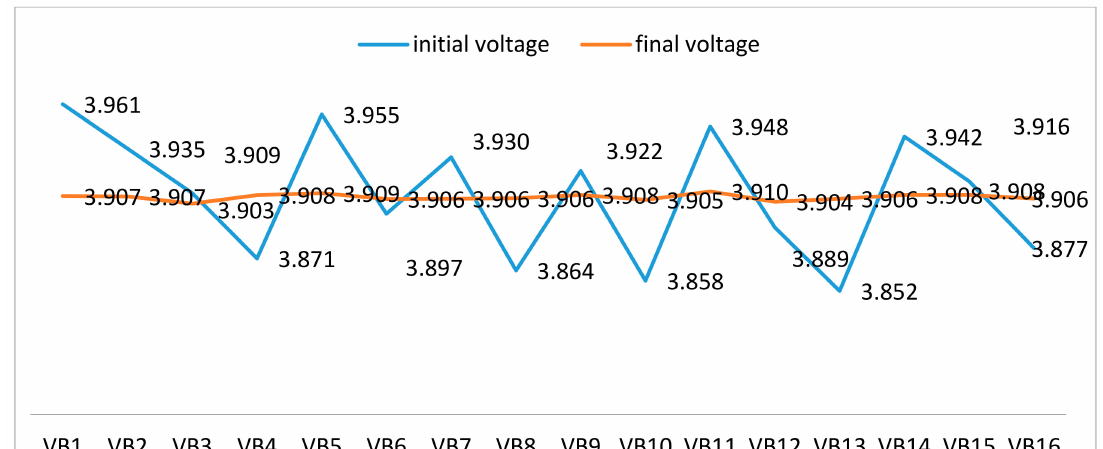
Figure 12. Voltage of16 cells before and after